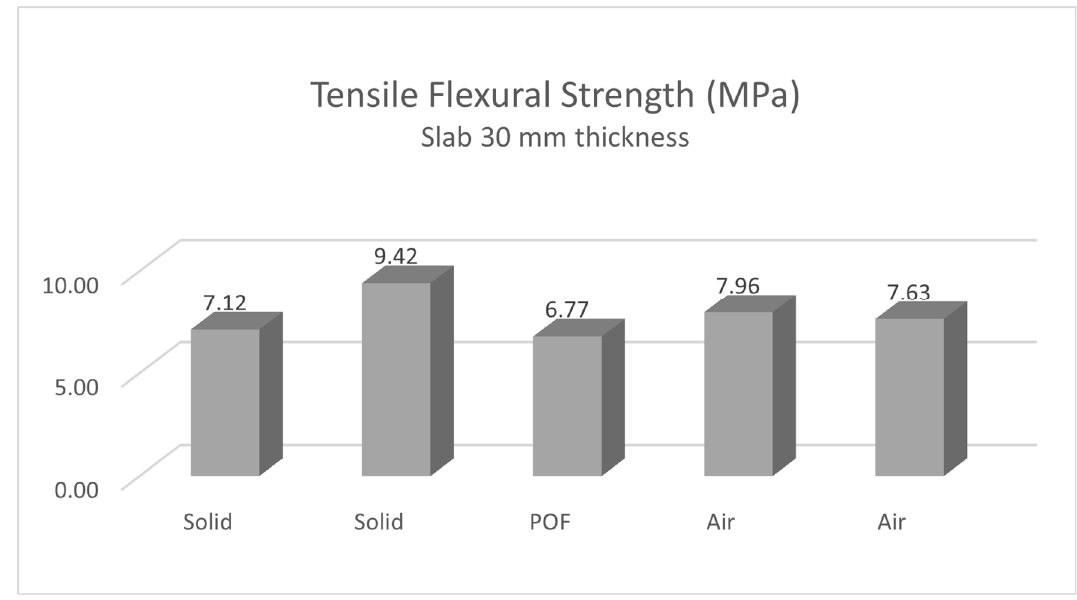
Figure 43. Tensile flexural strength of slabs of thickness 30 mm.